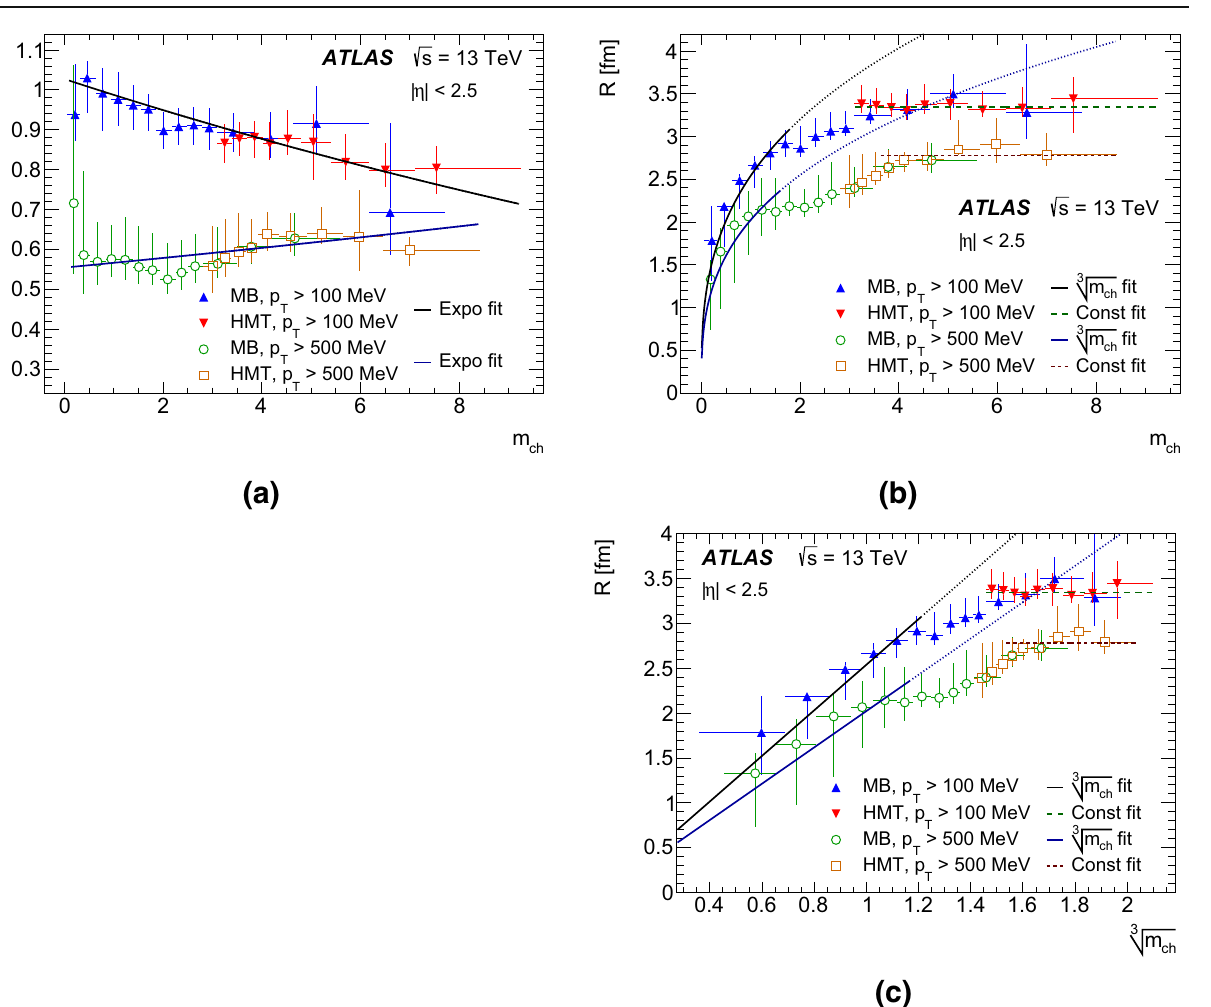
in a represent the exponential fit of λ( m ch ) for p T > 100 MeV and p T > 500 MeV, respectively. The black and blue solid curves in b √ m ch < 1 . 2 for p T > 100 MeV and represent the fit of R ( m ch ) for 3 p T > 500 MeV, respectively. The black and blue dotted curves are √ m ch > 1 . 2, extensions of the black and blue solid curves beyond 3 √ m ch . respectively. The black and brown dashed curves represent the satura- √ m ch > 1 . 45 with p T > 100 MeV and for tion value of R ( m ch ) for 3 √ m ch > 1 . 6 with p T > 500 MeV, 3